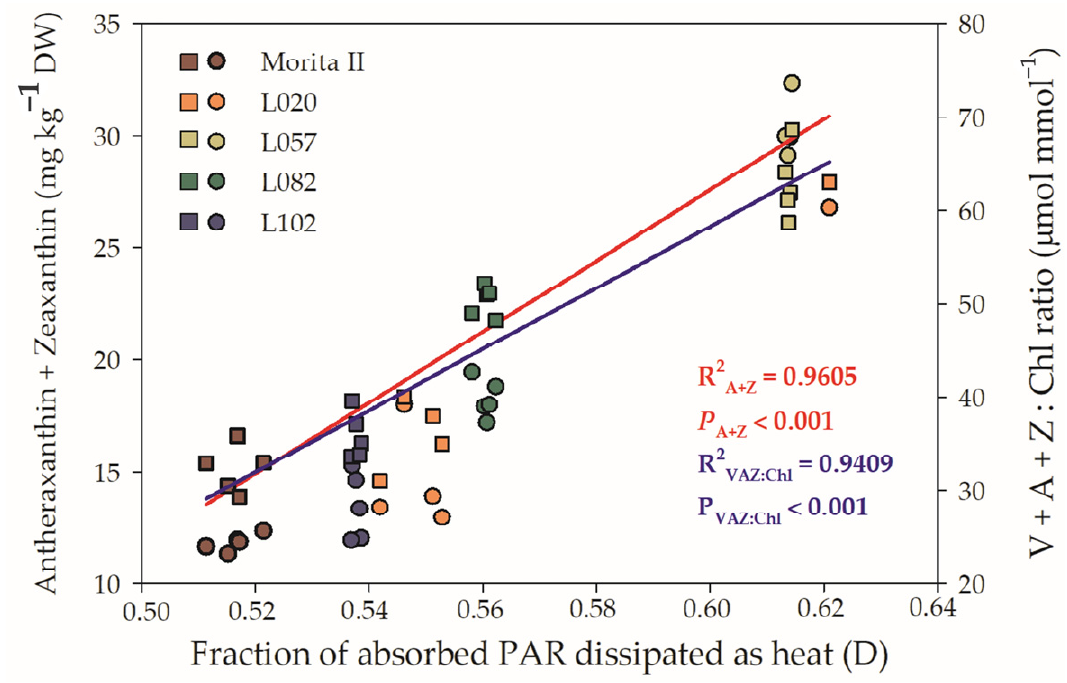
Figure 9. Relationship between fraction of absorbed PAR dissipated as heat (D) and Antheraxanthin + Zeaxanthin (left y axis) and Violaxanthin + Antheraxanthin + Zeaxanthin Chl − 1 (right y axis) evaluated in genotypes of Stevia rebaudiana (Morita II, L020, L057, L082, and L102) under land conditions in the complete absence of any plant stress. The regression R 2 and p value are shown.